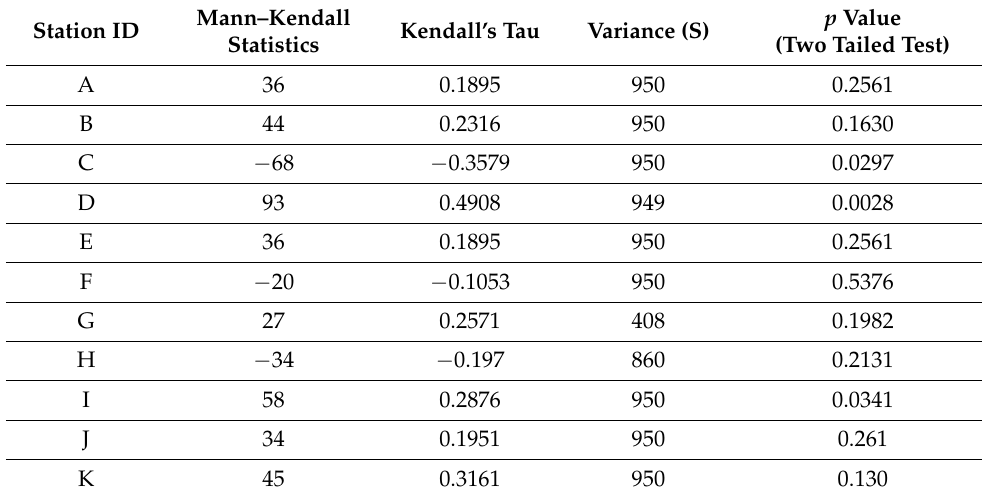
Table 5. Mann–Kendall test results for T min for Meteorological stations.